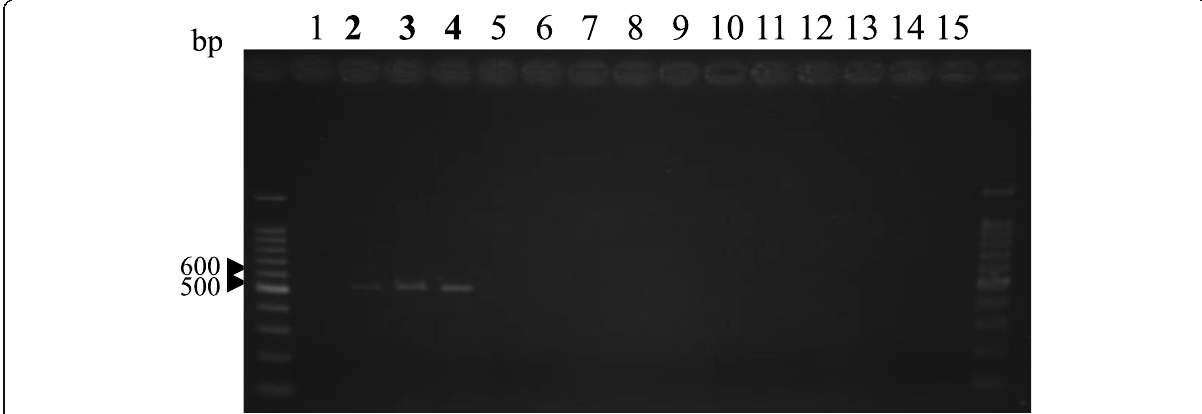
Fig. 1 Amplified products obtained by the primer pair hopRC/hanFC. Lanes 1 – 4: lily isolates of Fusarium oxysporum pathogenic to lilies; lanes 5 – 7: non-pathogenic isolates of F. oxysporum obtained from lily roots; lane 8 – 14: tester isolates of F. oxysporum ; lane 15: negative control. Marker used was 100 ladder